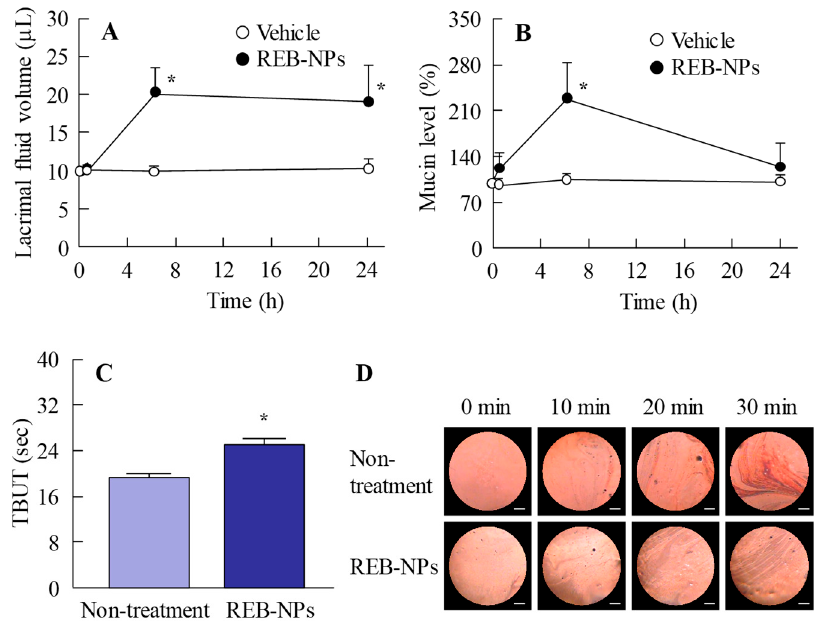
Figure 5. E ff ect of a single application of REB-NPs on lacrimal fluid volume, mucin levels, and TBUT in rabbits. ( A ) Changes in lacrimal fluid volume and ( B ) mucin levels after the application of REB-MPs or REB-NPs. ( C ) Changes in TBUT in rabbits treated with or without REB-NPs. ( D ) Images of the ocular surface over the range of 0-30 min after eyelid opening in rabbits treated with or without REB-NPs. The bar indicates 1 mm. In Figure 5C,D, REB-NPs measurements were begun 6 h after the application of the formulation to the eyelid. n = 6. * P < 0.05, vs. REB-MPs for each group. The application of REB-NPs induced an increase in lacrimal fluid volume, mucin levels, and TBUT in the rabbit eye and led to the stabilization of the ocular surface.